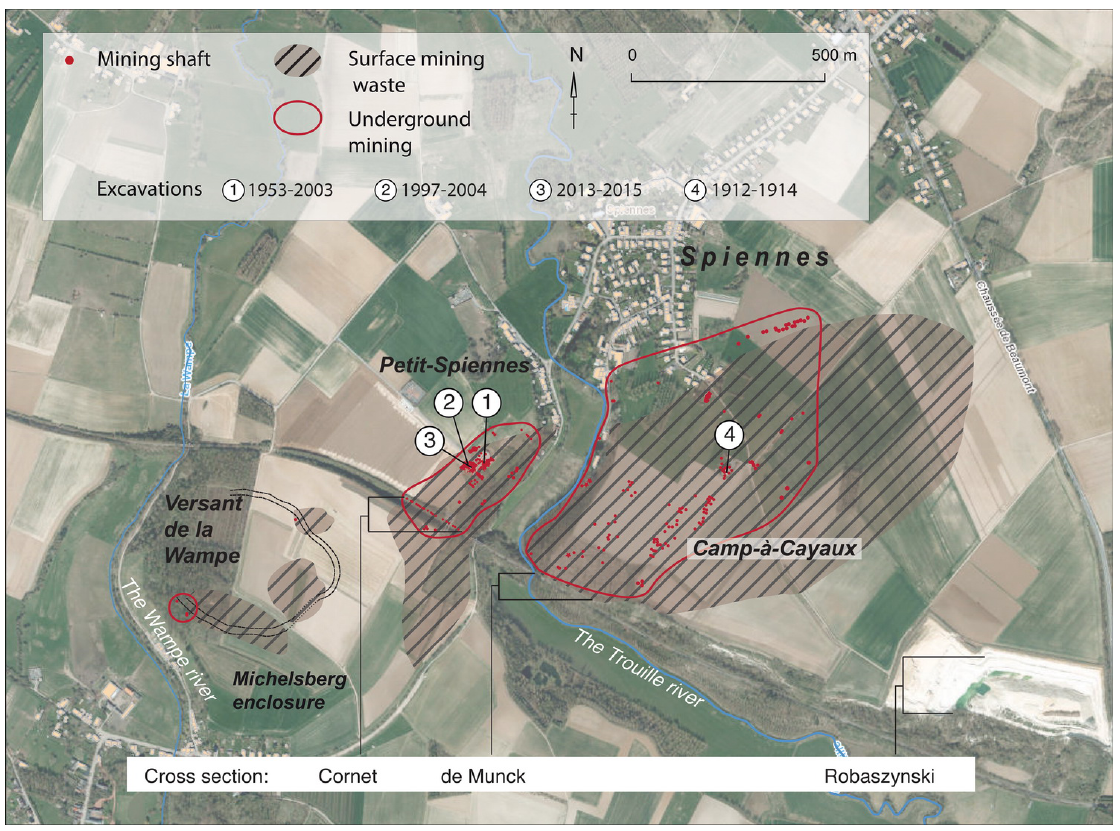
Figure 4. The Neolithic flint mines, surface extent of the mining waste and localisation of the known mining zones. (Surface extent after Gosselin (1990); background picture: SPW). Graphics by M. Woodbury, SPW.